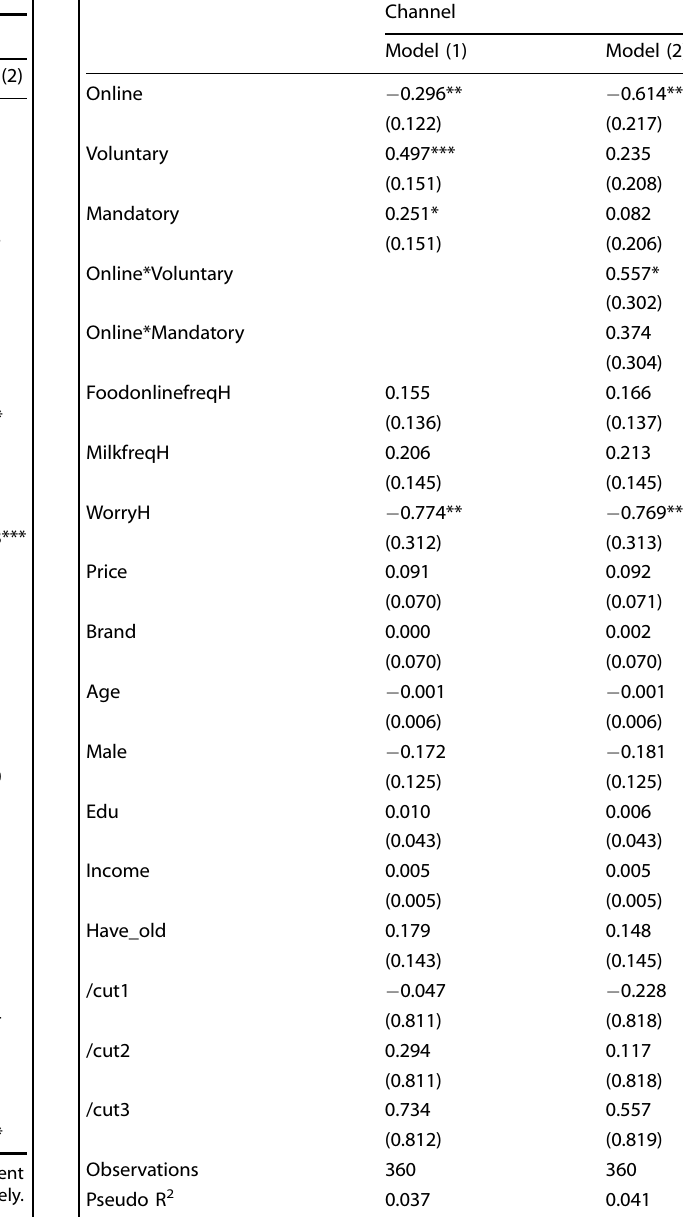
Table 4. Ordered probit model results of milk purchasing